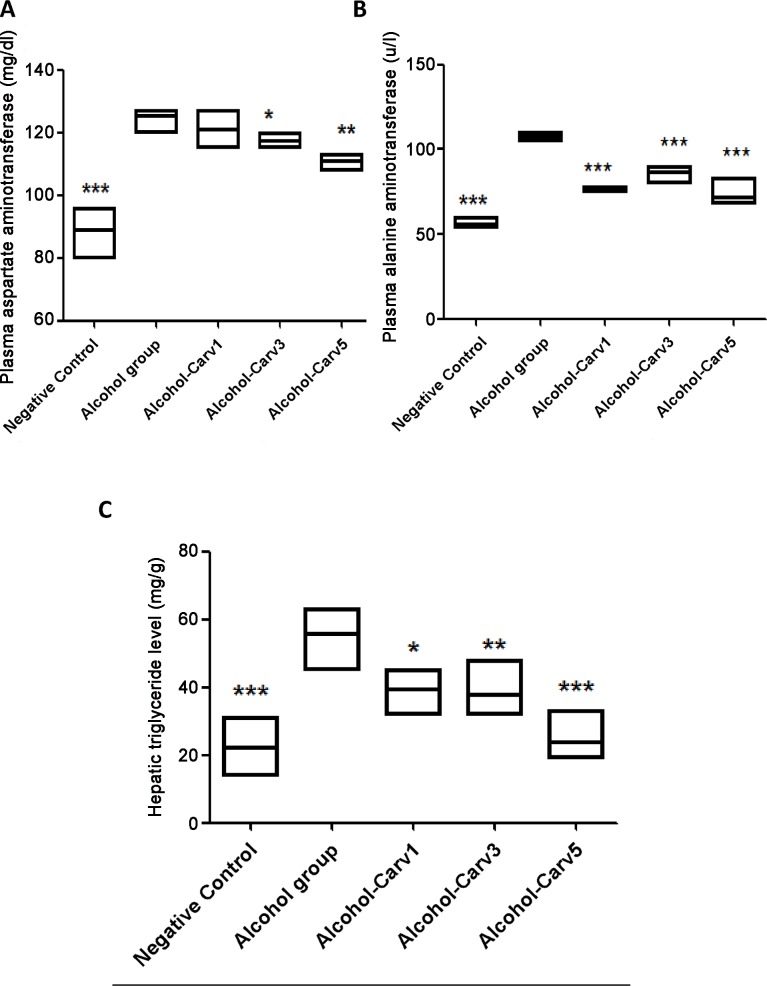
Biochemical analysis of blood AST (mg/dl), ALT (mg/dl), and triglyceride (mg/dl) levels in rats with alcohol-induced liver injury.CARV modified the ethanol-induced increases in levels of AST (A, n = 5, p < 0.01), ALT (B, n = 5, p < 0.01), and hepatic triglycerides (B, n = 5, p < 0.001). *p < 0.05, **p < 0.01, and ***p < 0.001 vs. the alcohol group and ***p < 0.001 for negative control vs. alcohol group (analysis of variance followed by Bonferroni’s correction).